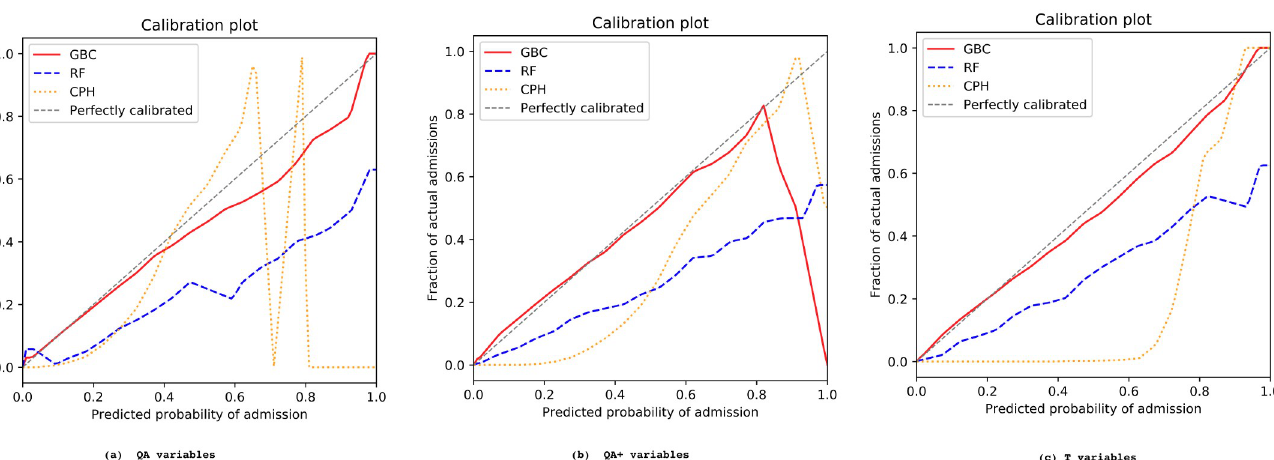
Predictor set T and GBC modelling constantly perform better than their counterparts. The results conform to the pattern observed in internal cross-validation.